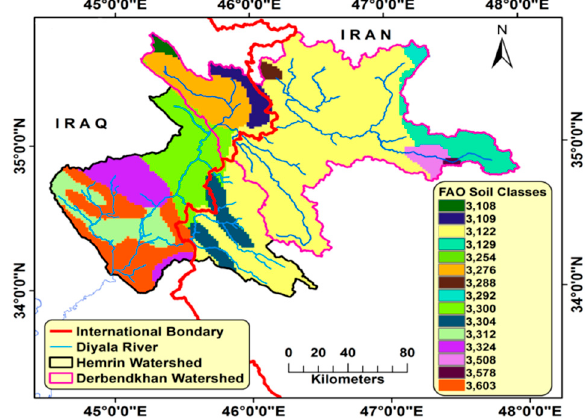
Figure 3. Moderate-Resolution Imaging Spectroradiometer (MODIS) land cover (500 × 500) m spatial resolution.